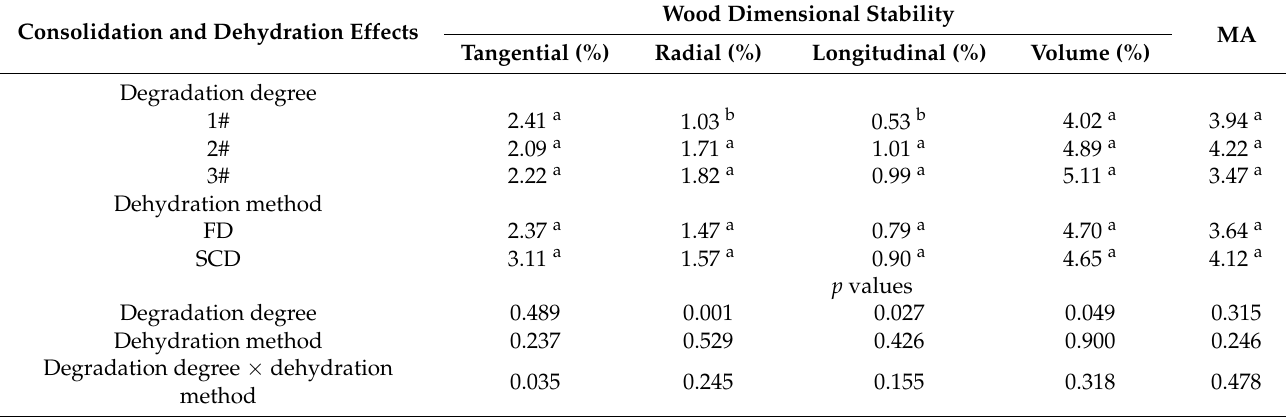
Table 3. Consolidation and dehydration effects on wood dimensional stability and moisture absorp-